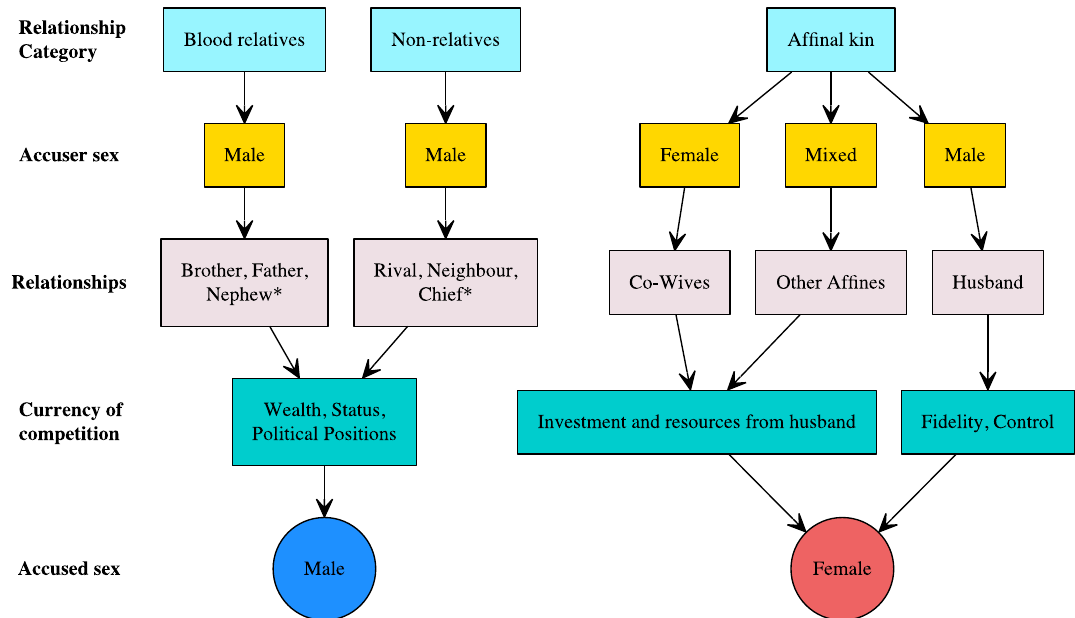
Figure 1. A visual representation of patterns of competition and how they may determine the sex of those accused of witchcraft. Relationship category indicates the broad category of relationship that an accusation might stem from. Accuser sex indicates the sex of an accuser. Relationship gives a more precise specification of the relationship the accuser to the accused (some of the relationship pairings that make up the Relationship Category). Where variables are marked with ‘*’, this means that accusations may stem from other forms of relationship but those given are likely to be common examples. Currency of competition indicates what is being contested between the accused and their accuser. Accused sex shows whether the accusation is likely to target a man or a